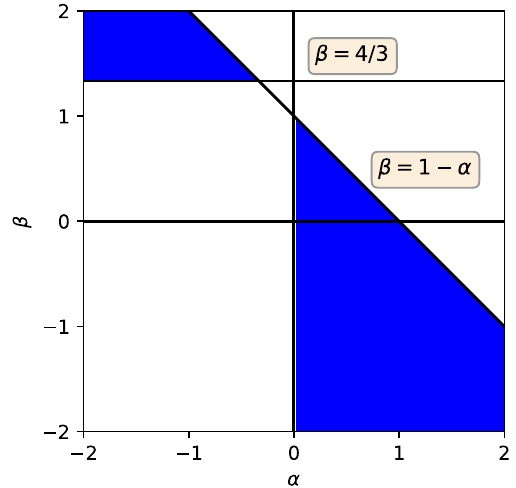
Fig. 5 Limits over free parameters for model M 5 . The blue regions correspond to values of parameters allowed by the conditions S (cid:7) ≥ 0, < 0 and S (cid:7)(cid:7) < S (cid:7)(cid:7) m h